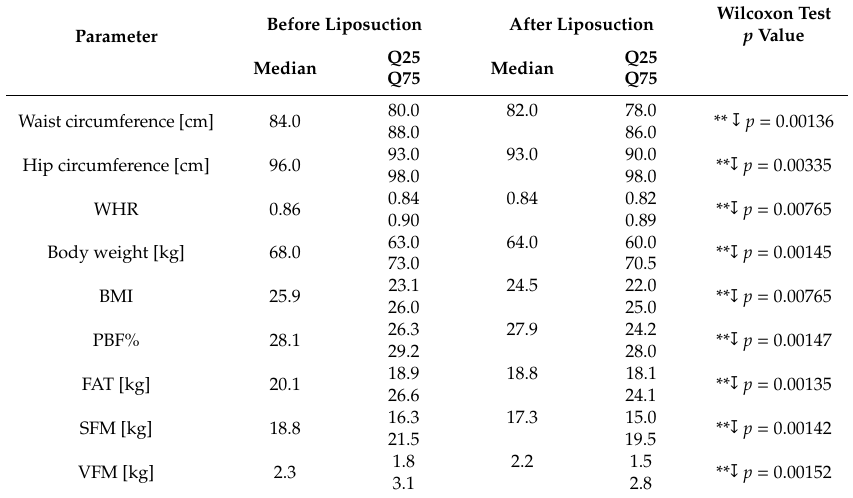
Table 1. The baseline values of haematological parameters in the examined women. Parameter M ± Sd